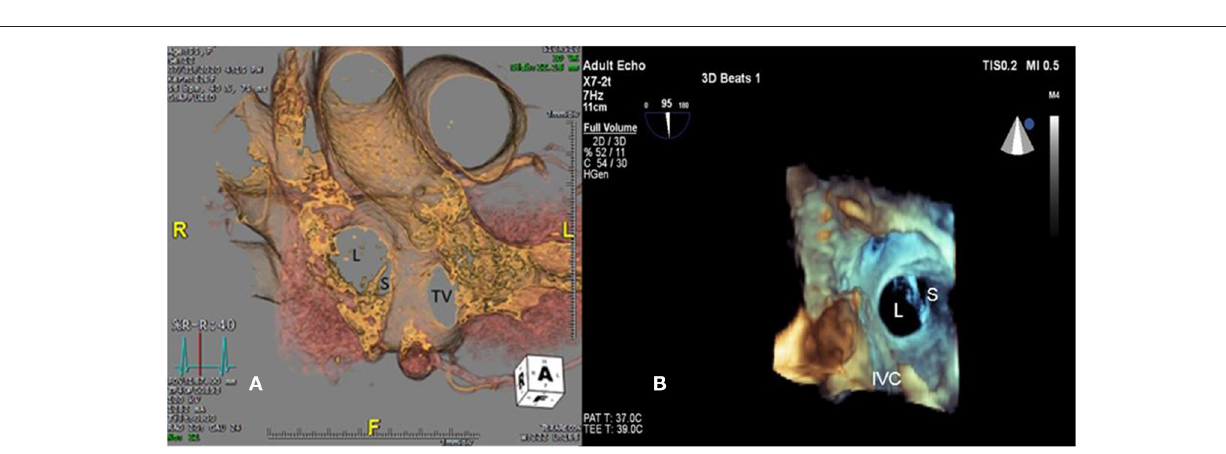
FIGURE 2 | Large (L) and small (S) ASDs are revealed in (A) cardiac computed tomography and (B) three-dimensional transesophageal echocardiogram. TV, tricuspid valve.